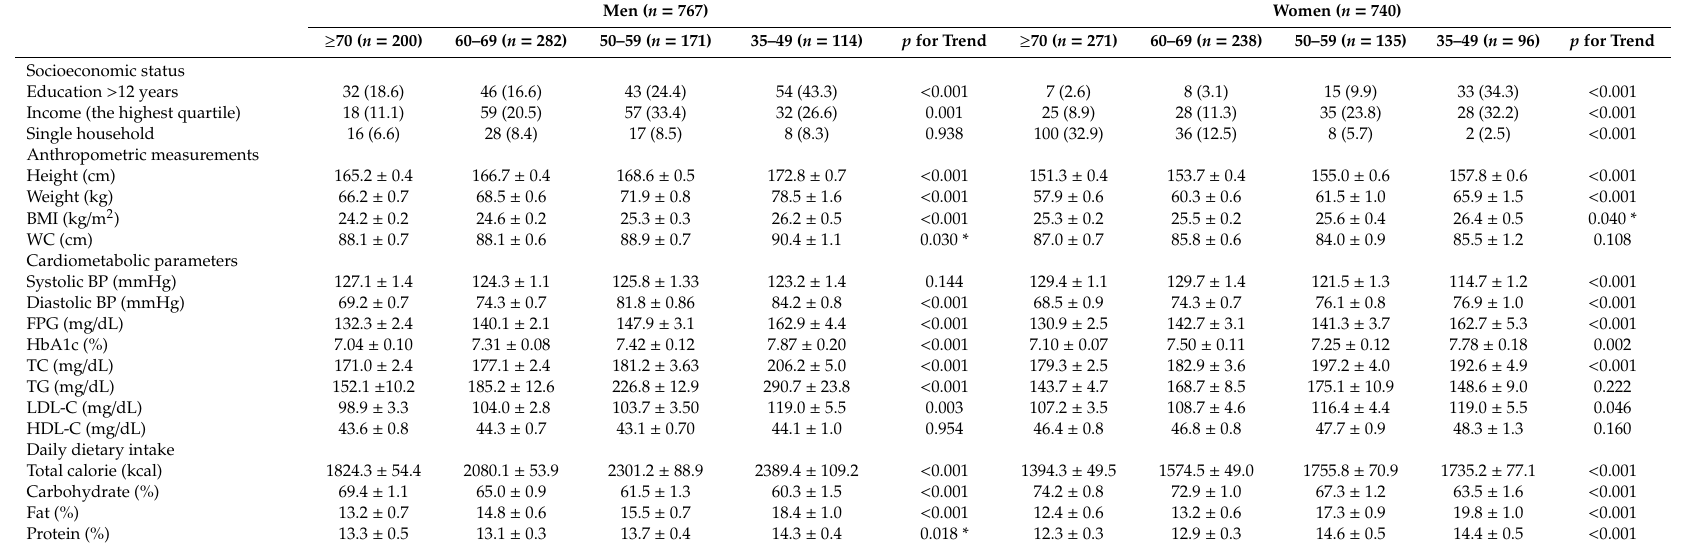
Table 1. Cardiometabolic and nutritional characteristics according to age groups among patients with